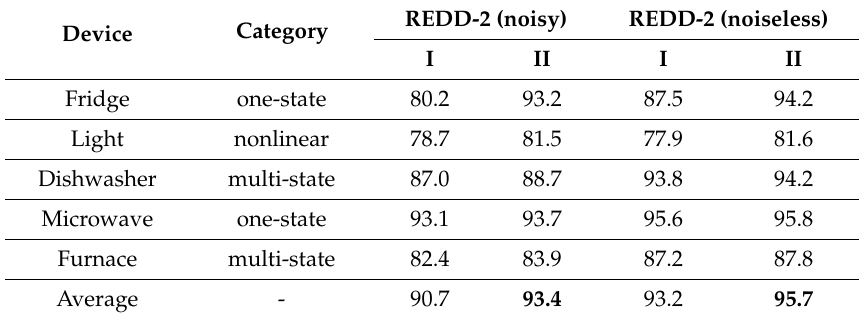
Table 5. Performance evaluation E ACC (%) for five selected appliances from the REDD-2 dataset for both one-stage (I) and proposed two-stage fusion (II)